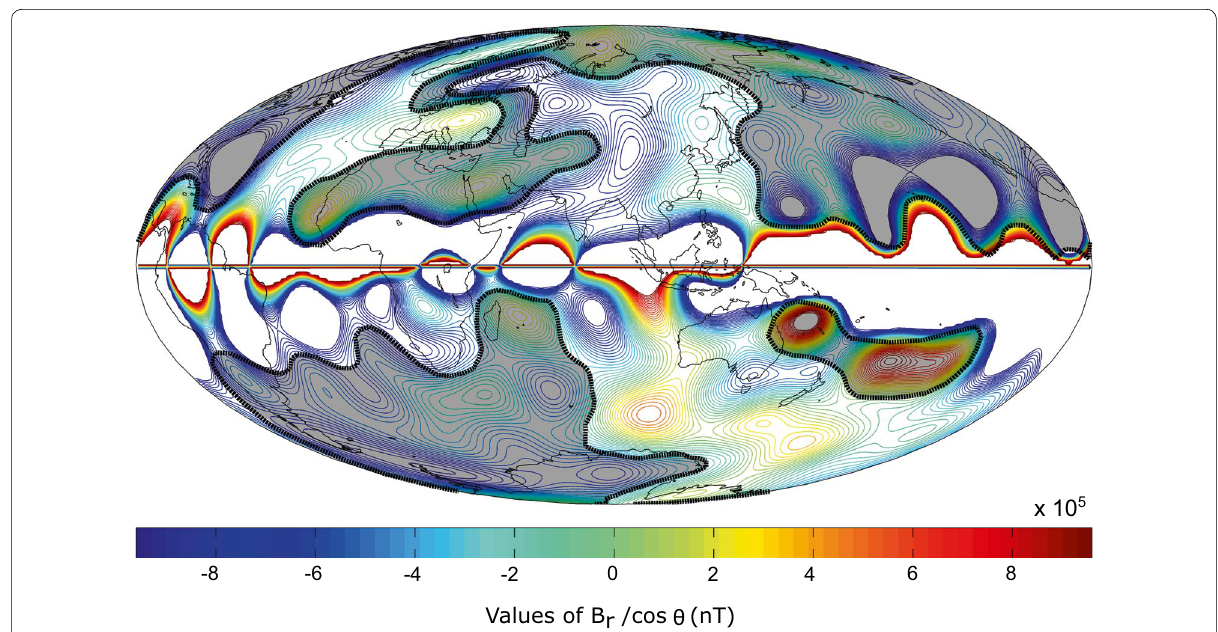
Fig. 1 Tangentially geostrophic ambiguous patches used in decomposition. Contours of B r / cos θ for values less than 10 6 nT . The shaded regions are the area considered to be ambiguous when the tangentially geostrophic assumption is applied. These regions were defined by considering the locations of closed contours which do not connect to the equator. The B r values are from the 2015 IGRF field model (Thébault et al. 2015). This and all other figures in this projection are centered on longitude 90 ◦